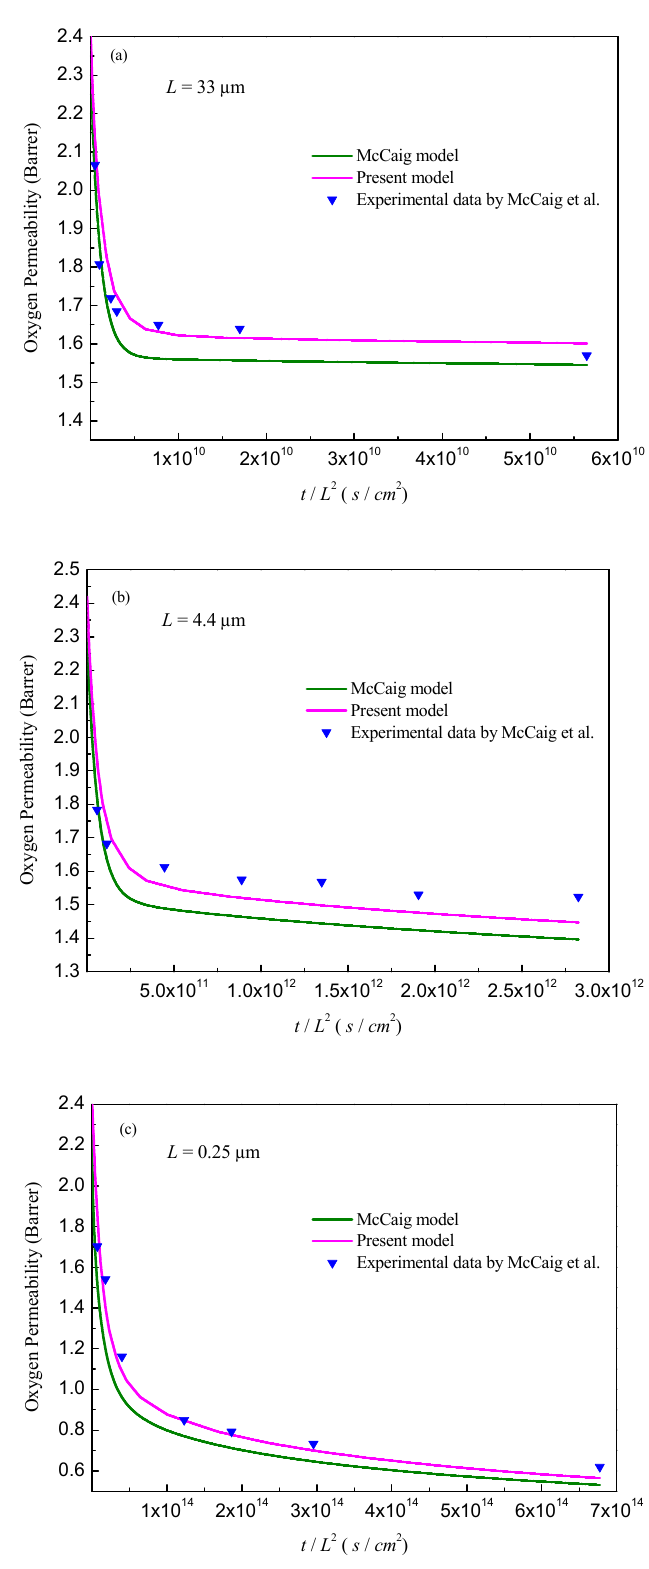
Figure 2. Comparison of the present model with the existing McCaig’s model [21]: ( a ) Film thickness: L = 33 μ m; ( b ) L = 4.4 μ m; and ( c ) L = 0.25 μ m.